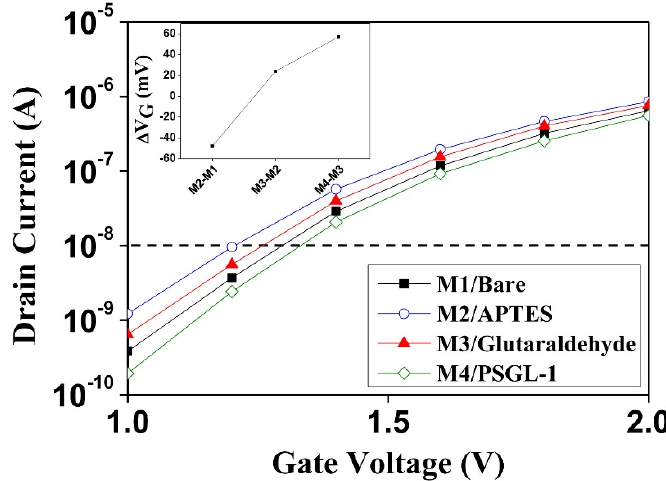
Figure 4. Electrical responses of the functionalized pSNWFET following each modification process. I D –V G curve obtained from the unmodified surface following the modification of the pSNWFET with APTES, glutaraldehyde, and PSGL-1 peptide. In set figure represent the changes of voltage at 10 −8 A following each surface modification step.